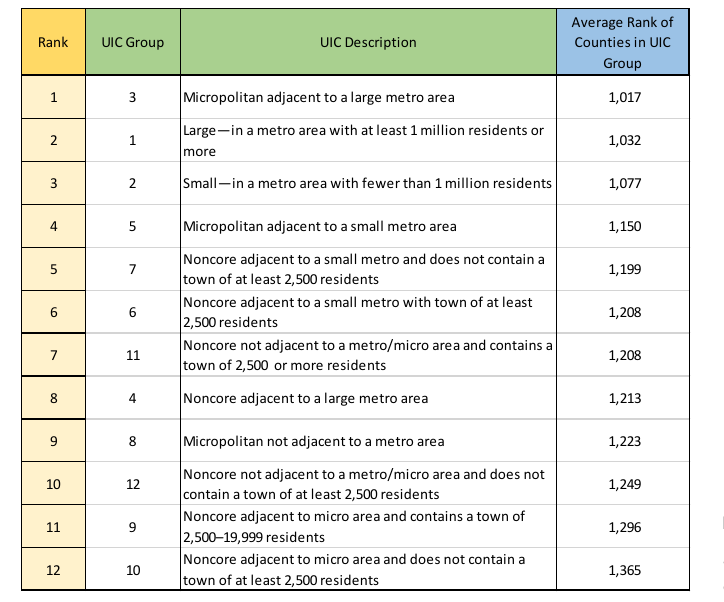
Table 18. UIC Group Ranking: Organic Sales,